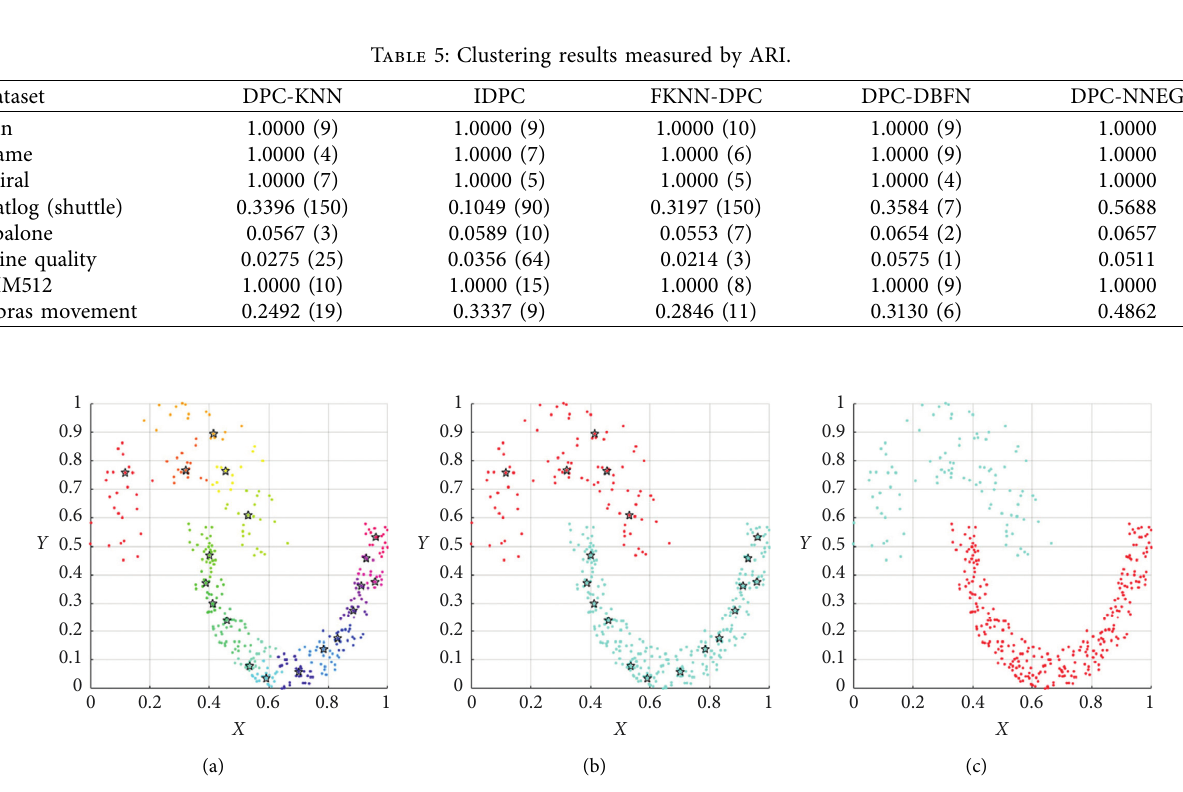
Figure 5: The clustering results of the Jain dataset. The diverse colors present different NNEGs and clusters, and the stars mark the zero samples. (a) NNEGs of Jain. (b) DPC-NNEG on Jain. (c) Ground